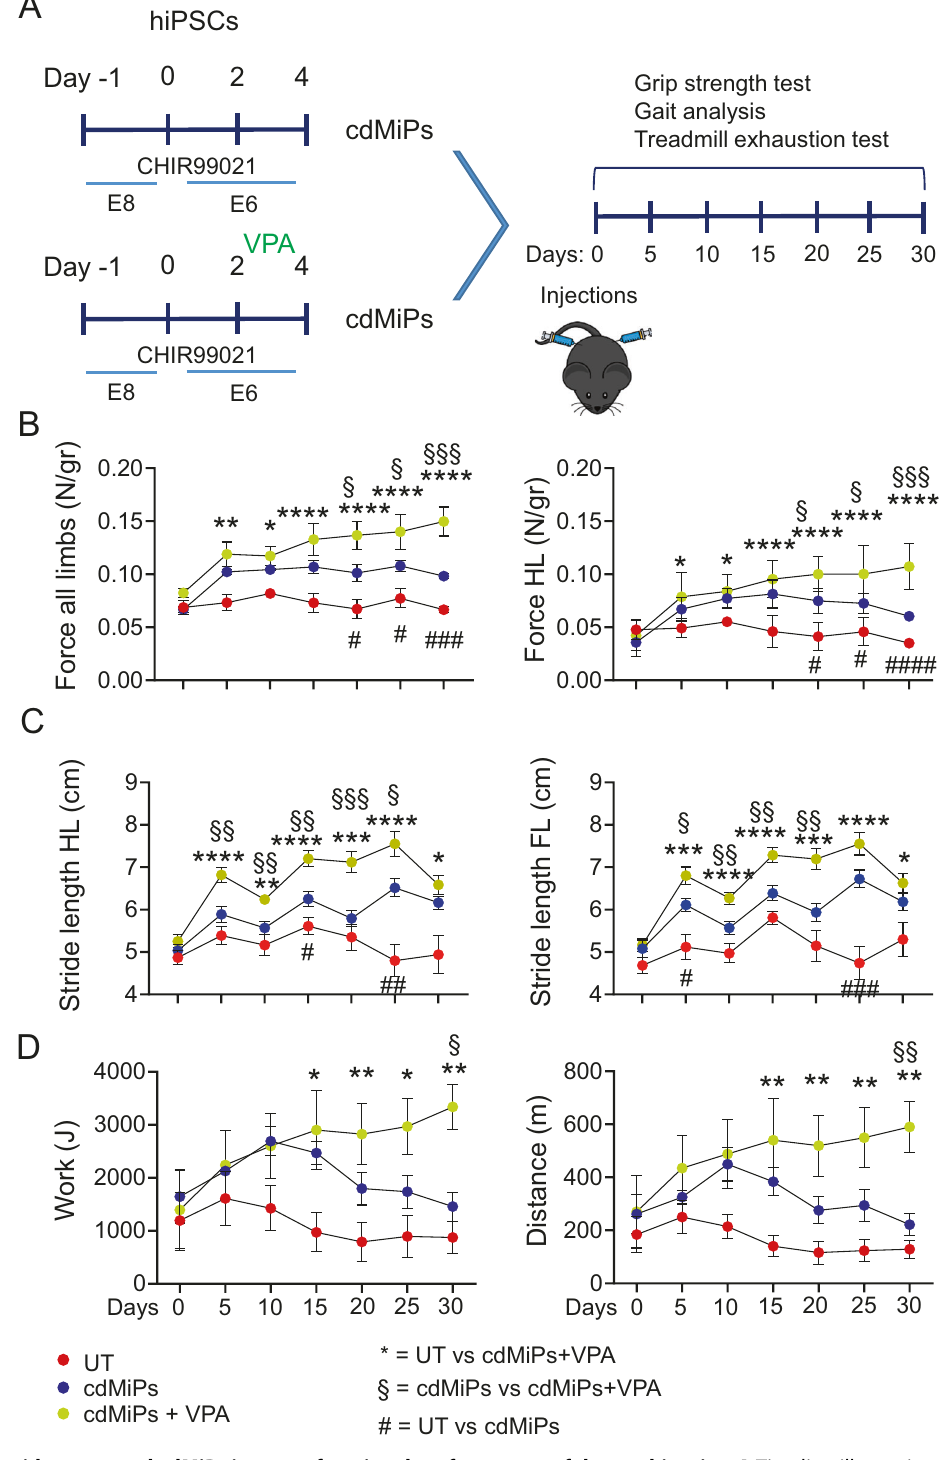
Fig. 7 Valproic acid pre-treated cdMiPs improve functional performances of dystrophic mice. A Timeline illustrating the experiment setup. At day -1, hiPSCs underwent the fi rst 4 days of skeletal muscle differentiation, with and without VPA treatment up to forming cdMiPs. After cell injection, Sgcb -/- /Rag2 γ c -/- dystrophic mice performed grip strength test, gait analysis, and treadmill exhaustion test at day 0, 5, 10, 15, 20, 25, and 30. B Grip strength test for all and hind limbs of UT, cdMiPs, and cdMiPs + VPA-treated mice showed as normalized force calculated as ration between the force (N) and the body weight of each mouse (N/gr). C Gait analysis for hind and fore limbs stride length of UT, cdMiPs, and cdMiPs + VPA-treated mice. D Treadmill exhaustion test of UT, cdMiPs, and cdMiPs + VPA-treated mice up to one month follow up. From left to right, graphs of Work (J) and Distance (m). All the functional tests were performed at day 0, 5, 10, 15, 20, 25, and 30. N = 4. *, § and # p < 0.05; **, §§ and ## p < 0.01; ***,§§§ and ### p < 0.001; ****,§§§§ and #### p < 0.0001 by two-way ANOVA. * UT vs cdMiPs + VPA. § cdMiPs vs cdMiPs + VPA. # UT vs